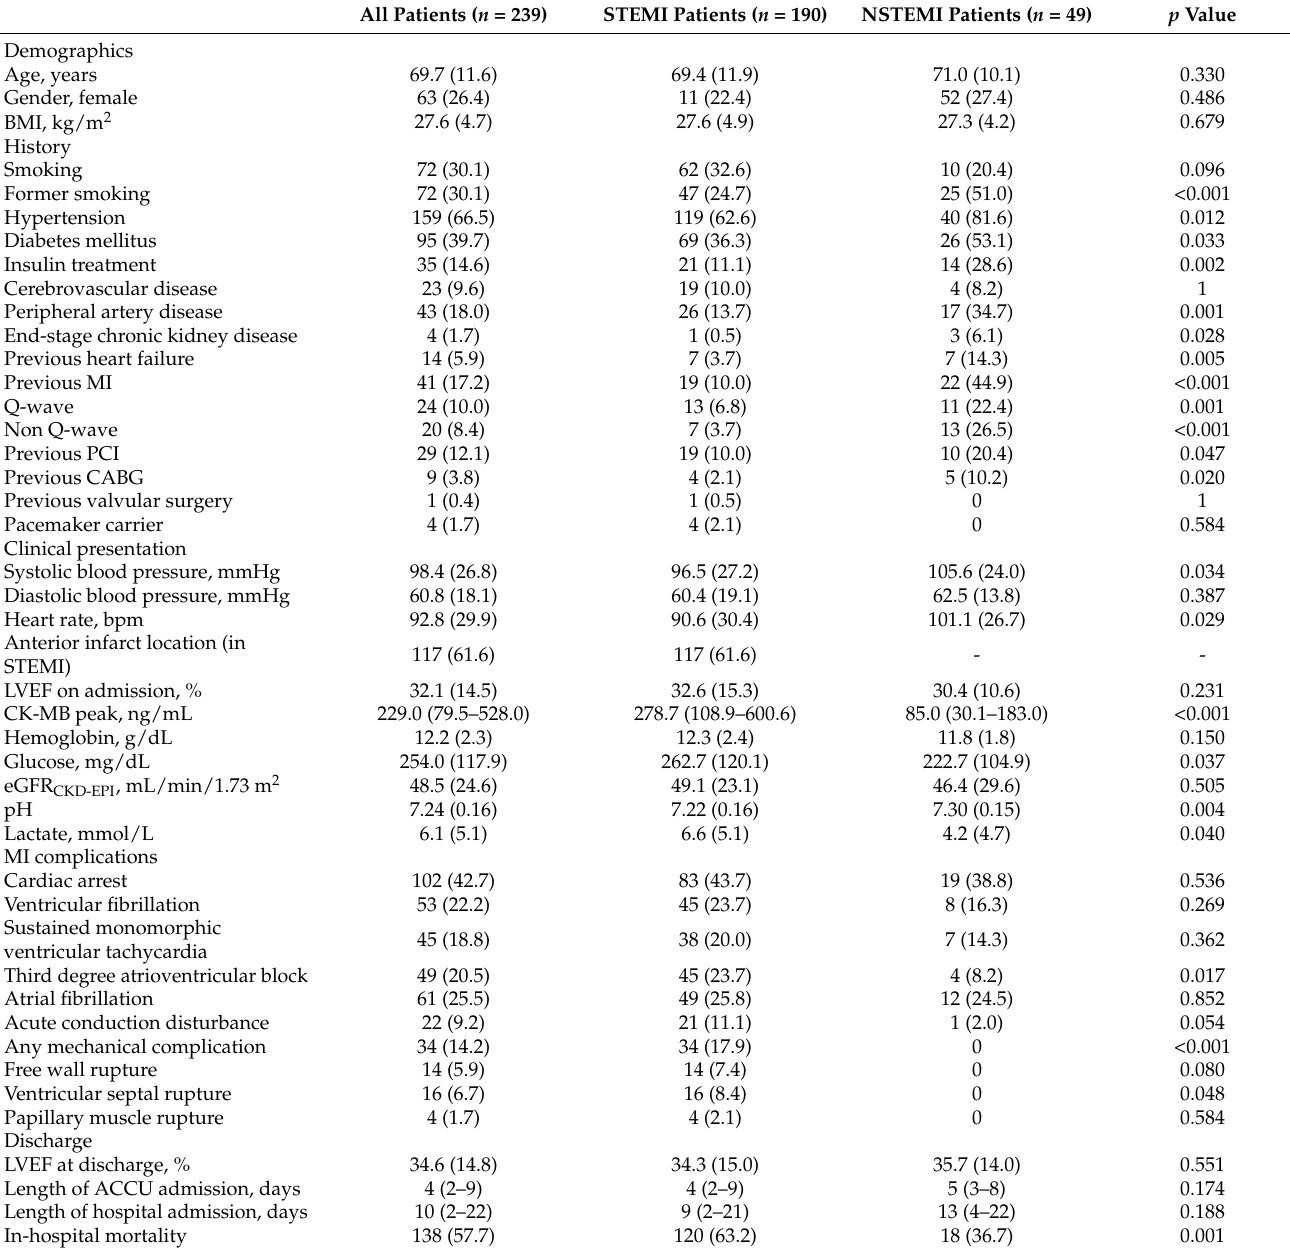
Table 1. Baseline characteristics and clinical course based on presentation with or without ST- segment